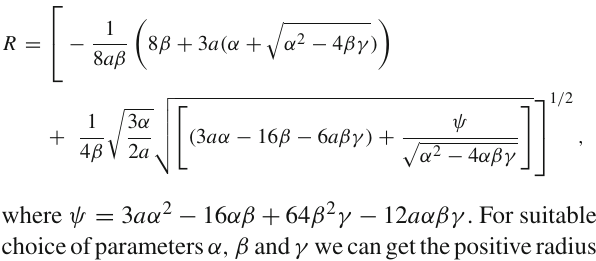
Fig. 1 Energy density